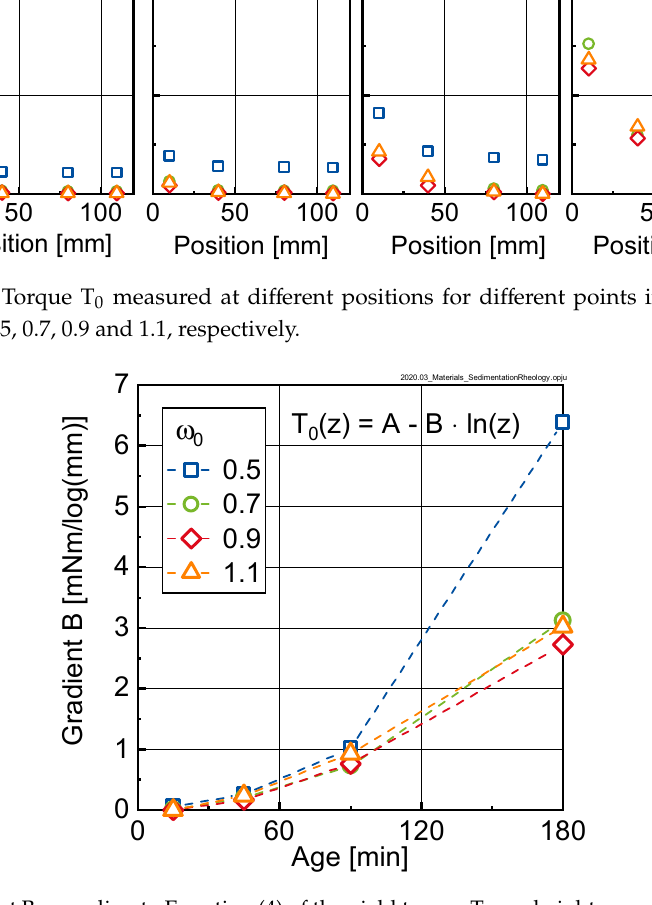
Figure 11. Gradient B according to Equation (4) of the yield torque T 0 vs. height z curves (see Figure 10) as a function of sample age for the investigated pastes (initial w / c-ratios ω 0 = 0.5, 0.7, 0.9 and 1.1).